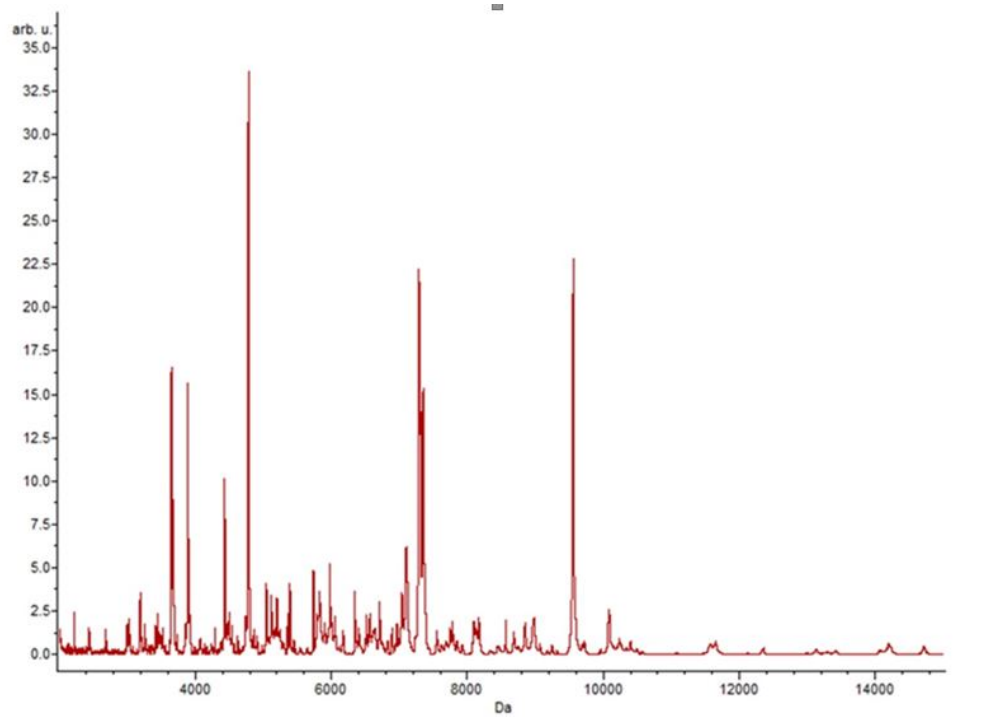
Figure 1. Representative spectrum of Enterococcus spp. without antibiotic. For all enterococci isolates, with and without antibiotics, a peak at m / z 4424.01 ± 3 was observed, representing a pertinent biomarker of the Enterococcus genus. A peak at m / z 6048 ± 1 was detected in all samples of E. faecium isolates, with a p -value of 0.00001, making this peak statistically significant and pointing to this as a putative biomarker of this species (Figure